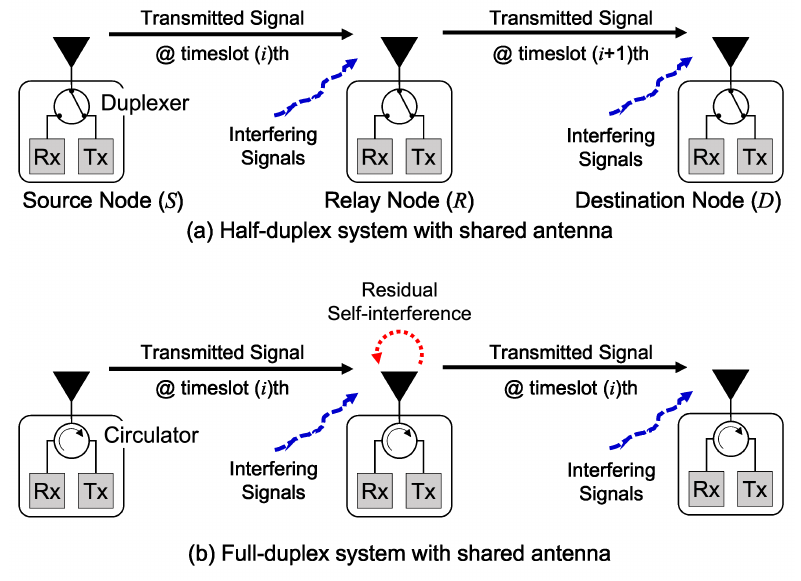
Figure 1. Two types of transmission mode in wireless